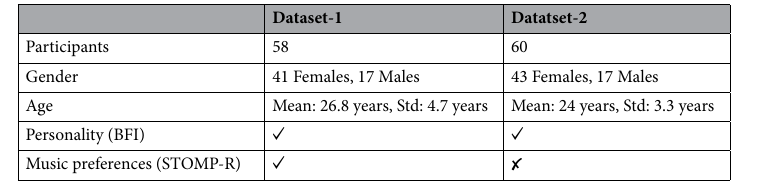
Table 4. Dataset